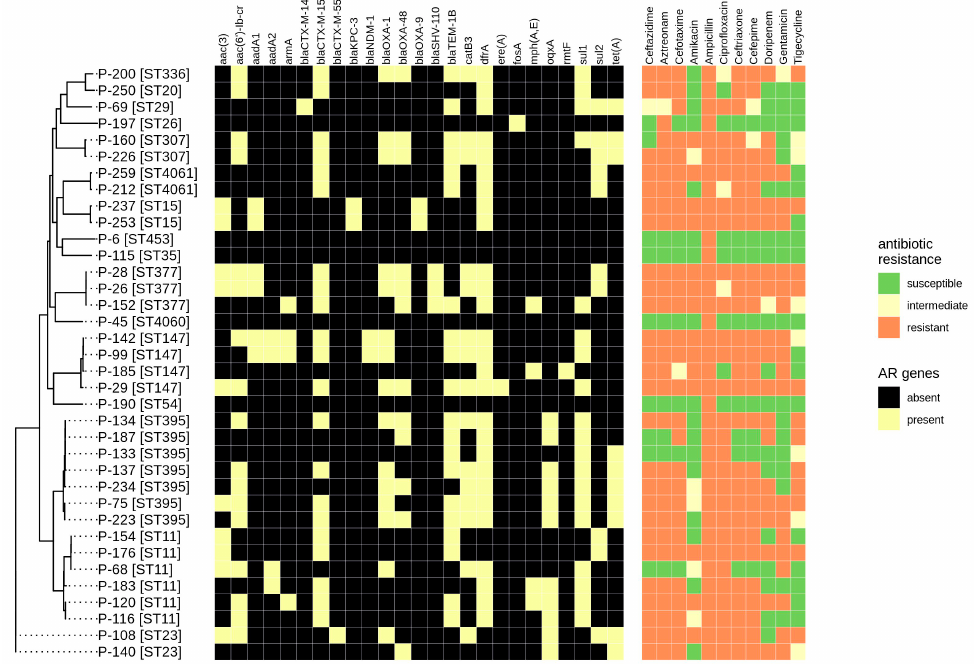
Figure 2. Phenotypic and genotypic antibiotic resistance profiles of the isolates studied. Results for colistin phenotype are described in the text.